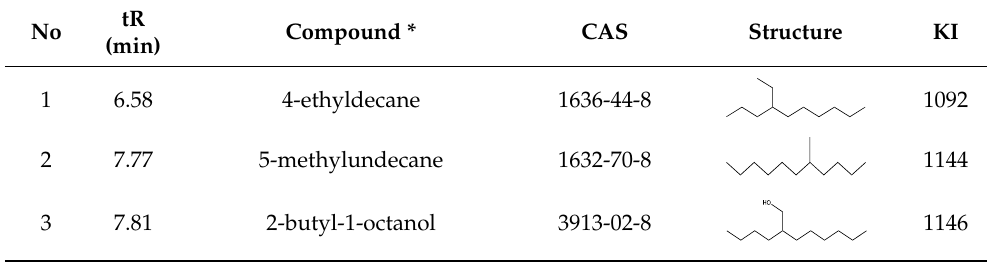
Table A1. Qualitative results of Arctostaphylos uva-ursi leaves (all samples) made by HS-SPME-GC-MS. List presents all compounds detected during the